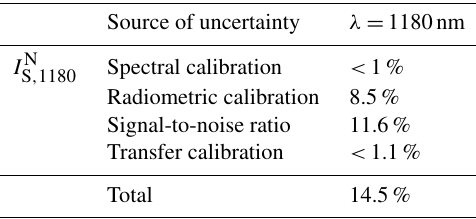
Table 2. Individual sources of uncertainty and total uncertainties for the upward radiance I N at a wavelength of λ = S , 1180